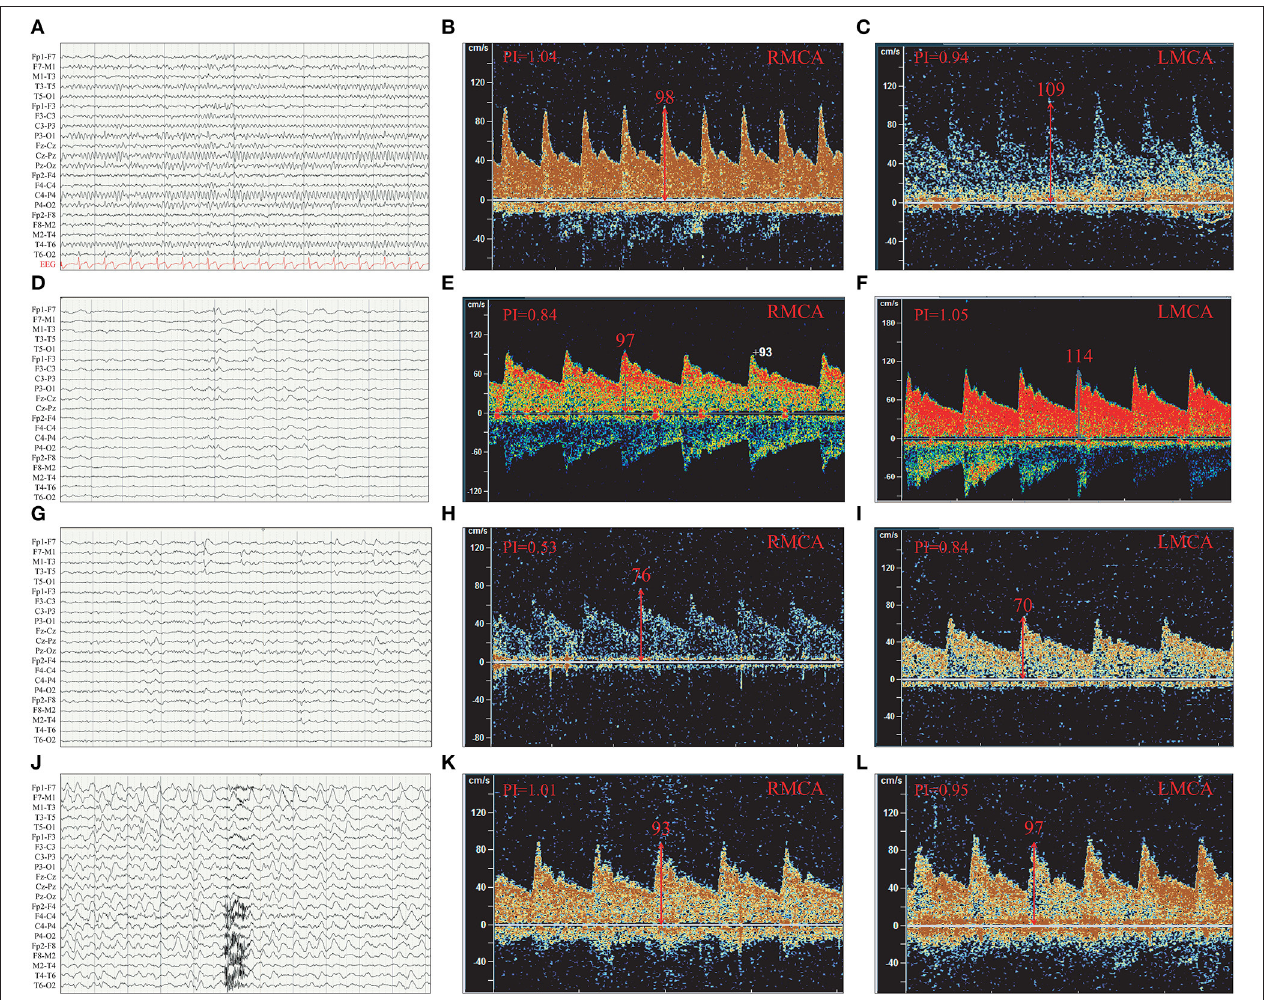
FIGURE 4 | The PFV of the left and right MCA were compared according to interictal EEG discharge patterns. (A) Normal EEG. (B) The PFV of RMCA was 98 cm/s. (C) The PFV of LMCA was 109 cm/s. (D) Left temporal discharge (unilateral discharge pattern); (E) The PFV of RMCA was 97 cm/s. (F) The PFV of LMCA was 114 cm/s. (G) Bilateral temporal asynchronous discharge (bilateral discharge pattern); (H) The PFV of RMCA was 76 cm/s. (I) The PFV of LMCA was 70 cm/s. (J) Bilateral multi-brain areas discharge (bilateral discharge pattern); (K) The PFV of RMCA was 93 cm/s. (L) The PFV of LMCA was 97 cm/s. (B,C) were case (A) ; (E,F) were case (D) ; (H,I) were case (G) ; (K,L) were case (J) ; R, right; L, left; ACA, anterior cerebral artery; MCA, middle cerebral artery; PCA, posterior cerebral